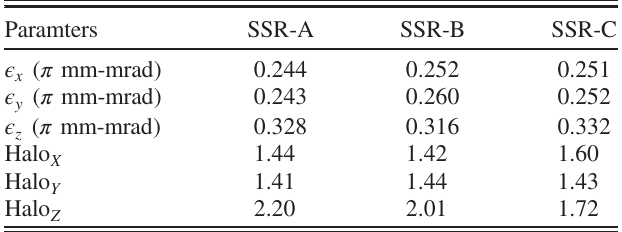
TABLE VIII. Beam parameters at the exit of the superconduct- ing section of MEHIPA linac.